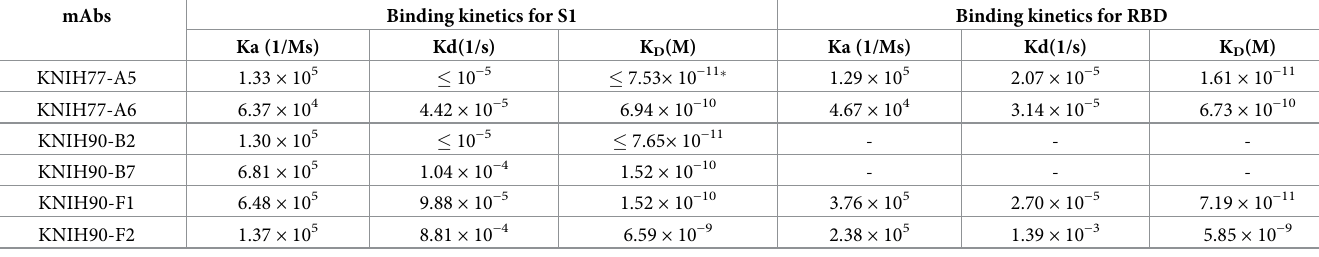
Table 2. Binding affinity of mAbs with potent neutralizing activity to MERS-CoV spike. mAbs Binding kinetics for